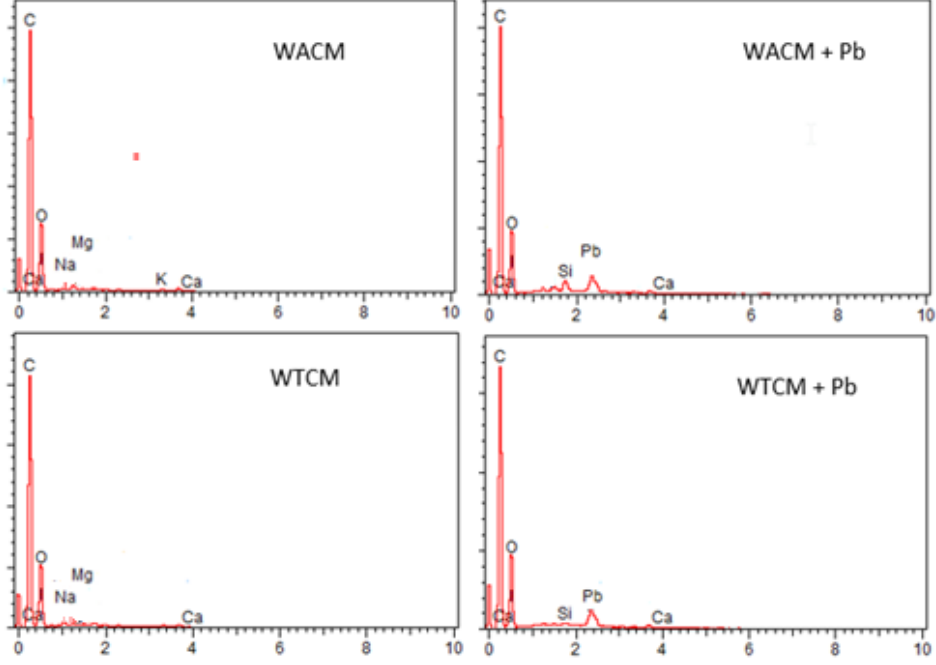
Figure 3. EDX spectra of WACM and WTCM before ( left ) and after Pb adsorption ( right ). pH = 4, C 0 = 130.8 mg L − 1 , T = 293 K, t = 120 min.